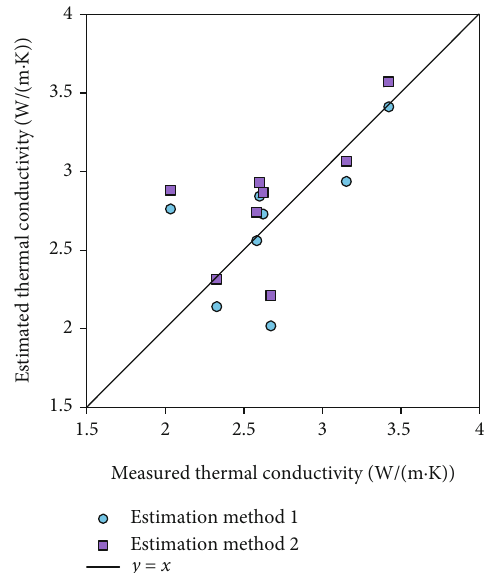
Figure 17: Comparison between estimated and measured results after